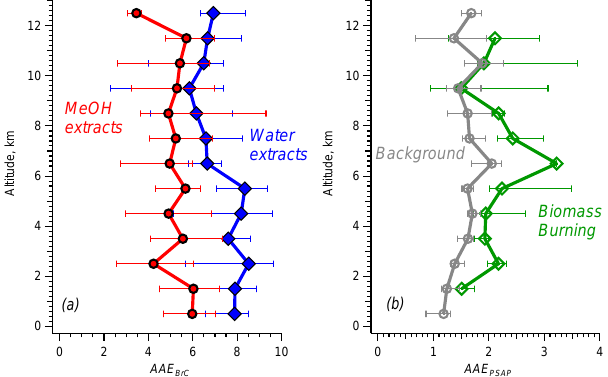
Figure 5. Vertical profiles of absorption Ångström exponent (AAE) of (a) BrC from solution spectra of both water extracts (blue line) and methanol extracts (red line), for background conditions, and (b) PSAP absorption measurements based on the wavelength combina- tion (470, 660nm), both background and biomass-burning impacted periods. Data were binned by 1km increments. Error bars indicated the inter-quartile